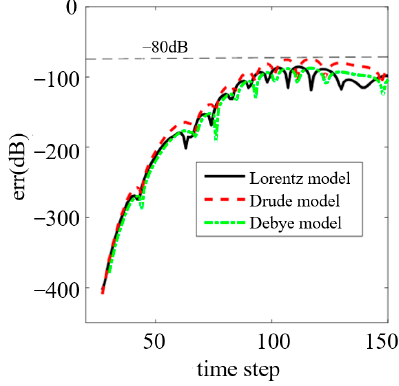
Figure 2. The reflection relative error of CPML in the three dispersion models.